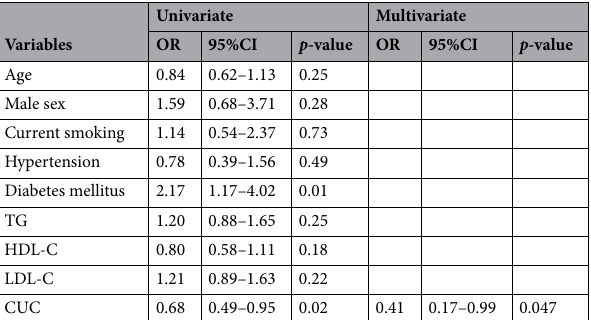
Table 4. Uni- and multivariate logistic regression analysis for revascularization. CI confidence interval, CUC cholesterol uptake capacity, HDL-C high-density lipoprotein cholesterol, LDL-C low-density lipoprotein cholesterol, OR odds ratio, TG